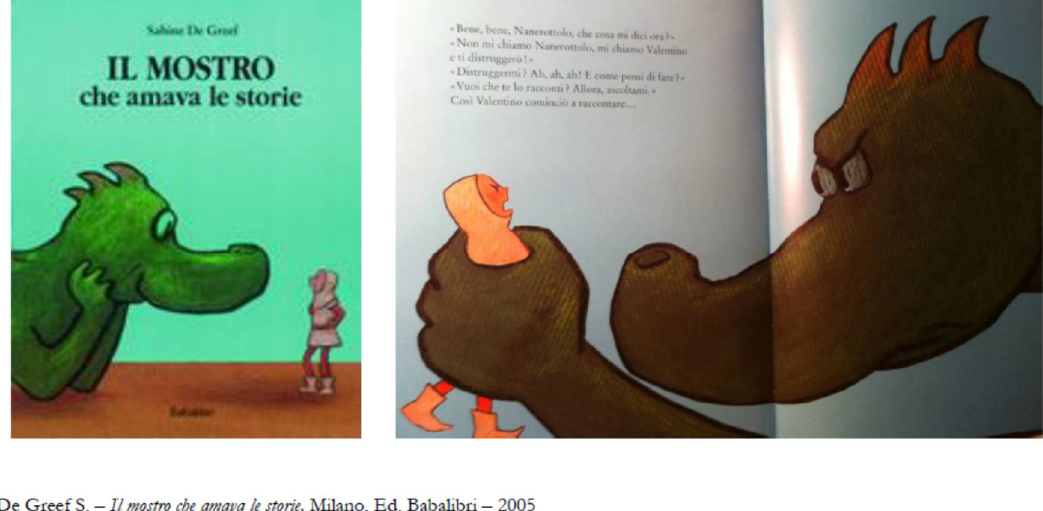
Figure A8. De Greef S.— Il mostro che amava le storie . Milano, Ed. Babalibri—2005.